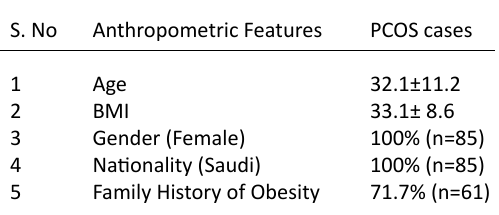
Table 1. Anthropometric features of involved PCOS women